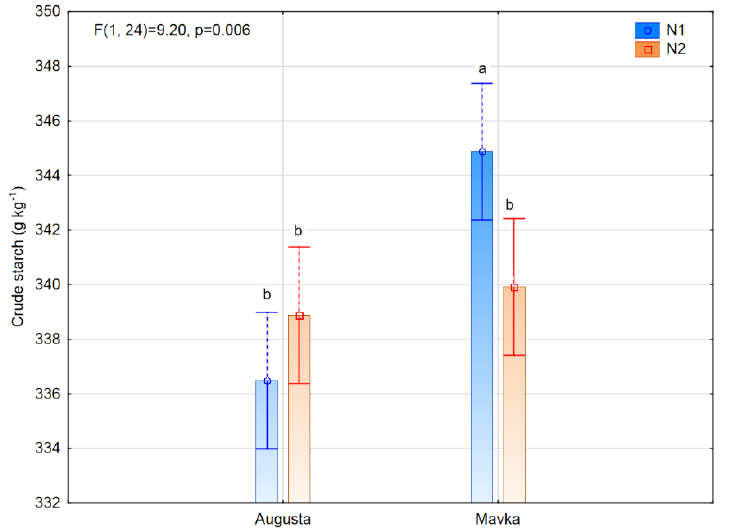
Figure 9. Significant interaction of cultivar and fertilization on crude starch (2015 year). The standard error (SD) of each mean is presented as a bar. The occurrence of the same letter pointer at averages (at least one) means that there is no statistically significant difference between them.